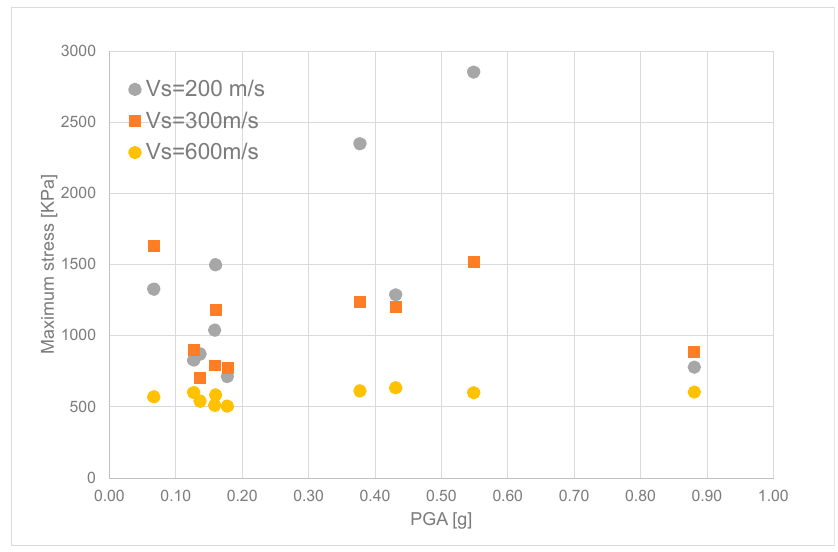
Figure 5. Comparison between results from Soil 1 and fixed based model.